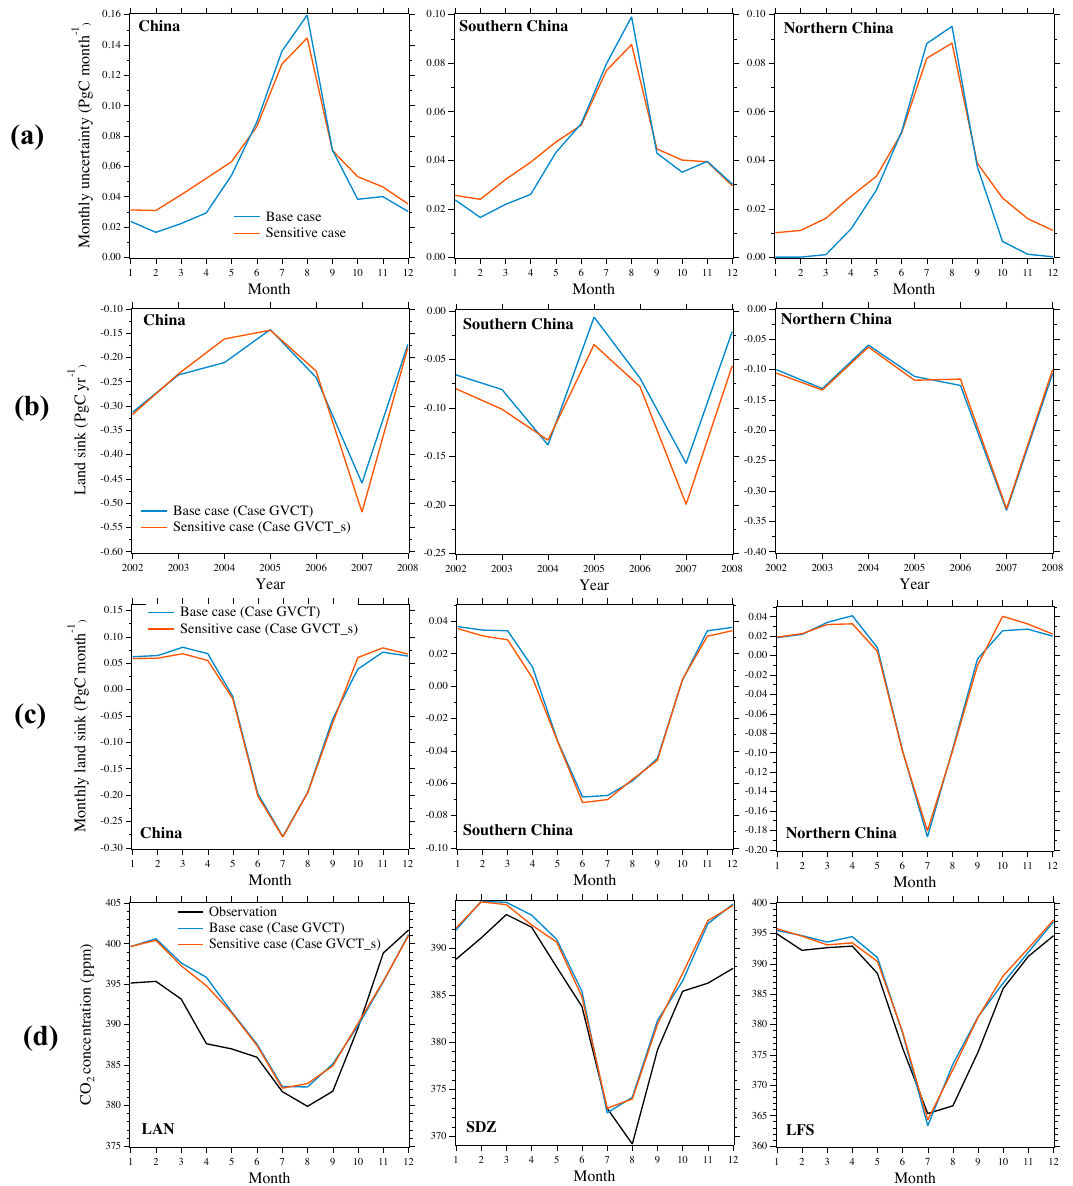
Figure 10. The sensitivity of the influence of (a) monthly prior flux uncertainty on the inverted carbon sinks over China, including (b) the inter-annual variations and (c) the monthly variations, as well as (d) the simulated CO 2 concentrations in 2007 at the three Chinese sites using the inverted carbon fluxes.